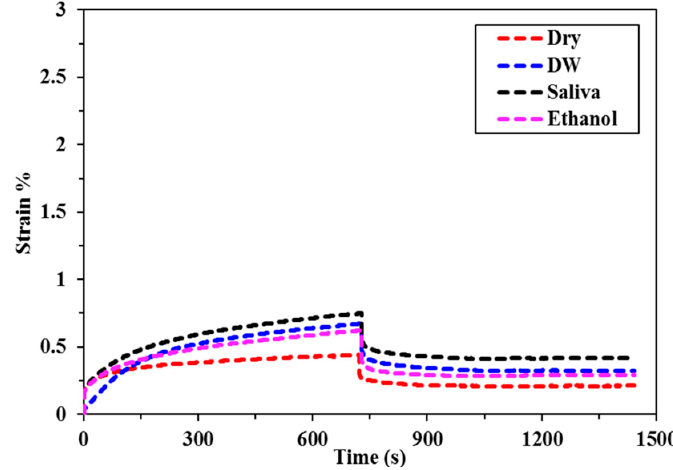
Figure 4. Creep deformation and recovery of SF2 in various FSOS.